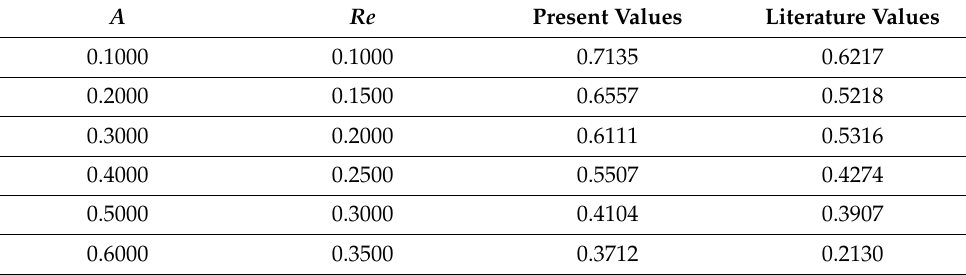
Table 7. Comparison of the present skin friction coefficient with the past literature.